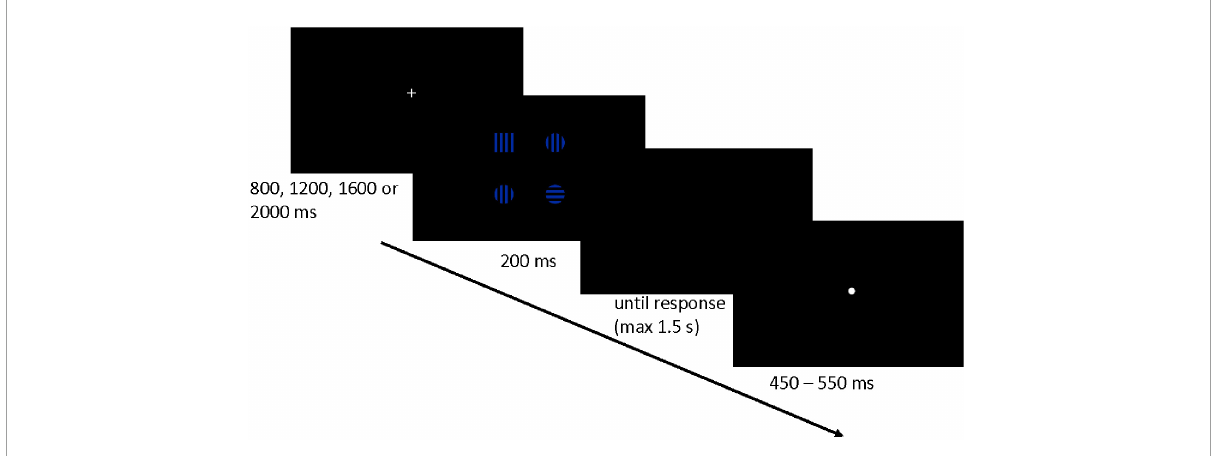
FIGURE1 The schema of the trial flow (For ease of the presentation, the size of the stimuli in the picture does not correspond to their real size on the computer screen).